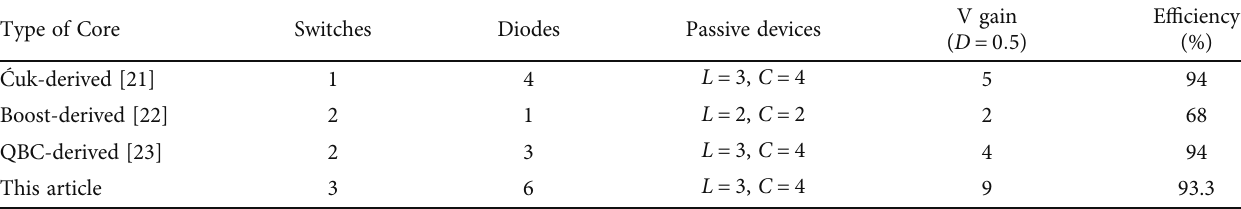
Table 5: A comparison of the features of some of the dual-output DC to DC converters. Type of Core Switches